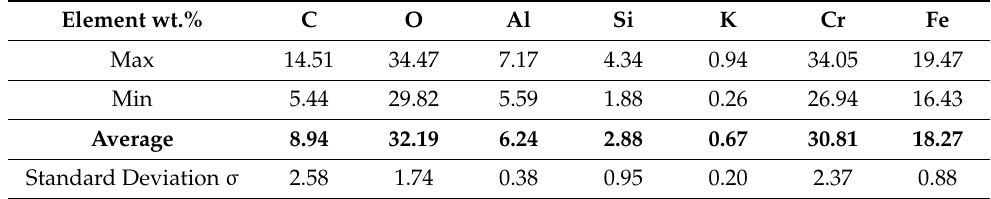
Table 5. Elemental wt.% contents of 10 min MR10M-reclaimed sand in the analysed area (in Figure 8b). Element